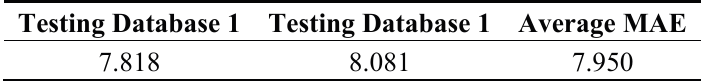
Figure 20. Examples of age estimation results in case of focused images, motion blur images with and without our proposed method and the de-blurred images using Wiener filter. Table 14. Age estimation accuracies using de-blurring filter (Wiener filter) on motion-blurred images of testing database 1 and